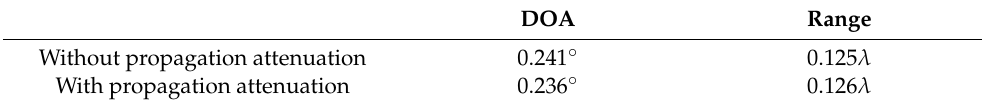
Table 2. The RMSE of the DOA and range estimation by the CVMD-based method. DOA Range Without propagation attenuation 0.241 ◦ 0.125 λ With propagation attenuation 0.236 ◦ 0.126